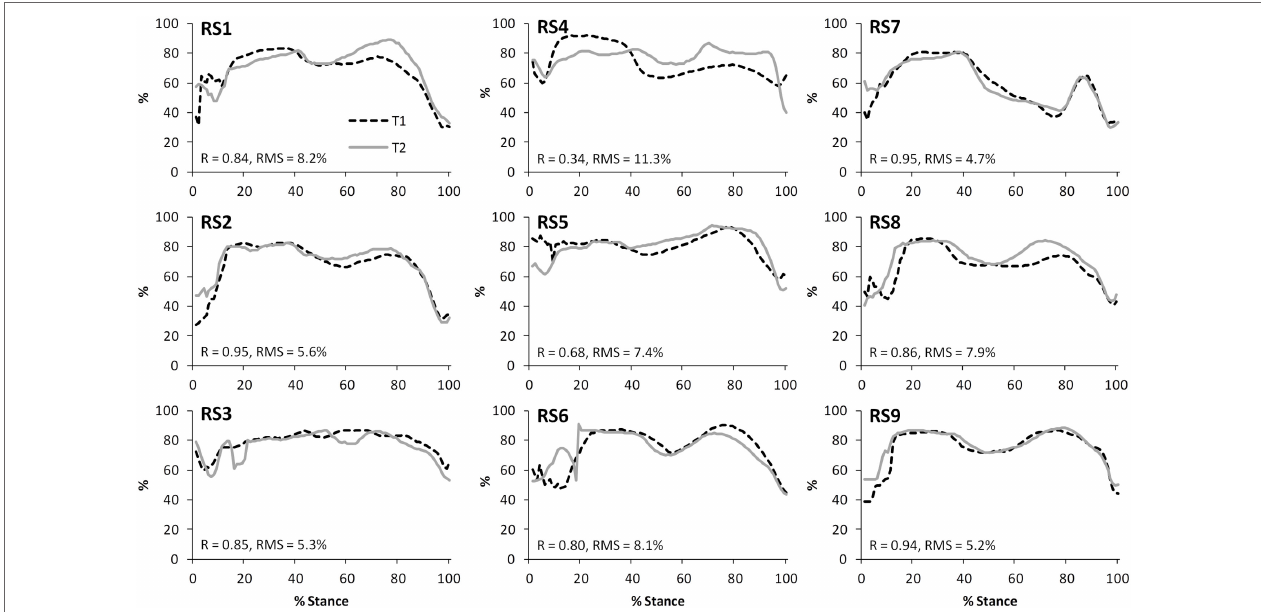
FIGURE 7 | A comparison of the subject-specific variation (between test sessions 1 and 2) in predictions of the proportion of the tibiofemoral joint contact force accounted for by the medial compartment during gait. Correlation coefficients ( R ) and root mean square errors (RMS) are also presented.